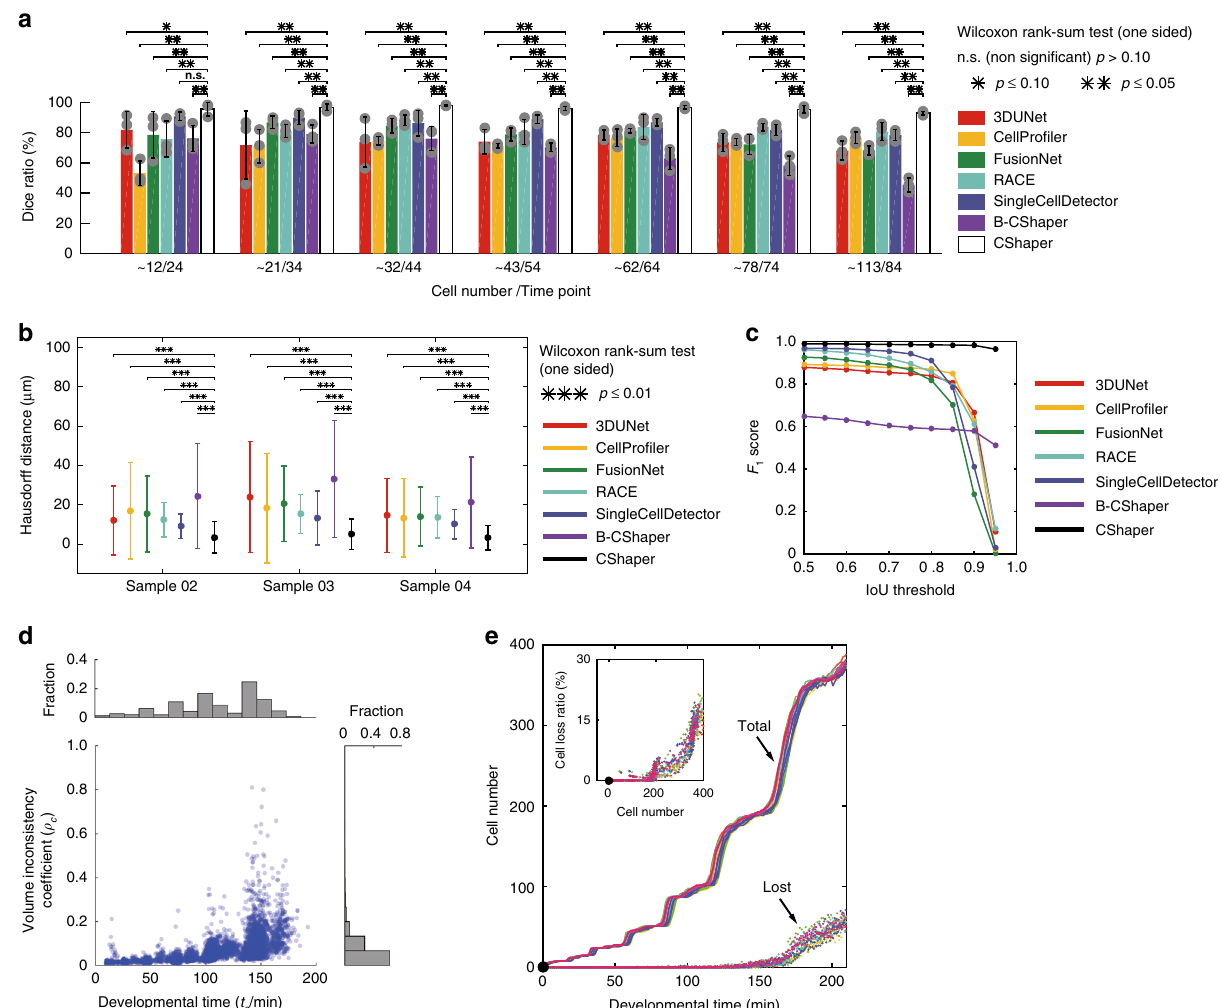
Fig. 2 Benchmarking of segmentation results. a – c Evaluations based on manual annotations of cells in three independent wild-type samples (02 – 04) with seven time points per embryo. a The dice ratio of the segmentations generated by 3DUNet, CellPro fi ler, FusionNet, RACE, SingleCellDetector, B-CShaper, and CShaper. Cell numbers are averaged at corresponding time points for each of the three embryos. Signi fi cance level is derived by one-sided Wilcoxon rank-sum test over n = 3 independent embryos (n.s. non signi fi cant, p > 0.10; * p ≤ 0.10; ** p ≤ 0.05); error bar represents standard deviation (SD). b The average Hausdorff distance between the segmentation results produced by these methods and the ground truth for each sample. Signi fi cance level is derived by one-sided Wilcoxon rank-sum test over n = 353, 261, and 470 independent cells for Samples 02 – 04, respectively (*** p ≤ 0.01); error bar represents standard deviation (SD). c Object-level F 1 scores based on 1084 independent cells at different IoU thresholds. d , e Statistics describing additional 17 samples (04 – 20) imaged and segmented spanning the 4 – to 350-cell stages. The embryos ’ time scales are proportionally normalized to their average. d Distribution of cell volume inconsistency coef fi cient ( ρ c ) over time ( t c ). e The number and ratio of lost cells over developmental time, where the last time point of the four-cell stage is set as the starting time point (indicated with a black point). Each color represents an individual embryo. Solid and dashed lines denote the total number of cells that were identi fi ed by nucleus tracing (total) and unsuccessfully segmented (lost), respectively. Source data are provided as a Source Data fi Supplementary Table 1. Note that for each segmented region, labels were uni fi ed according to the ground truth based on two principles, maximizing overlapped regions and assigning a unique label to each pixel. The dice ratio, as a pixel-level score, is widely used to measure the similarity between computational segmentation results and the ground truth. Given two areas, the dice ratio is de fi ned as the ratio between the overlapping region and the overall area 19 . After testing embryos at different cell stages, CShaper obtained a score of 95.95 ± 2.36%, outperforming other methods, in most cases by a signi fi cant margin (Fig. 2a, p ≤ 0.05, one-sided Wilcoxon rank- sum test). Therefore, in terms of the overlapped volume criteria, CShaper segmentation results were highly consistent with manual